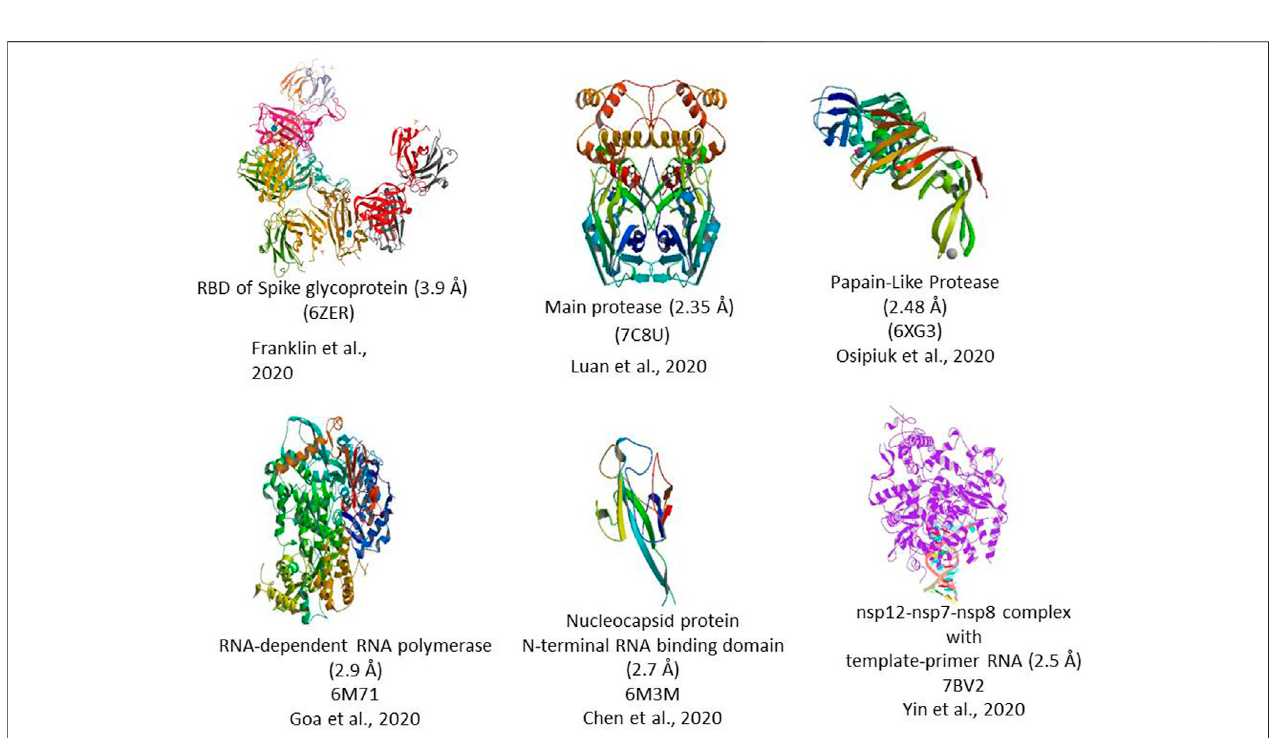
FIGURE 2 | 3D Crystal structure of prominent molecular targets of SARS-CoV-2. The structures were obtained from the Protein Data Bank (PDB).